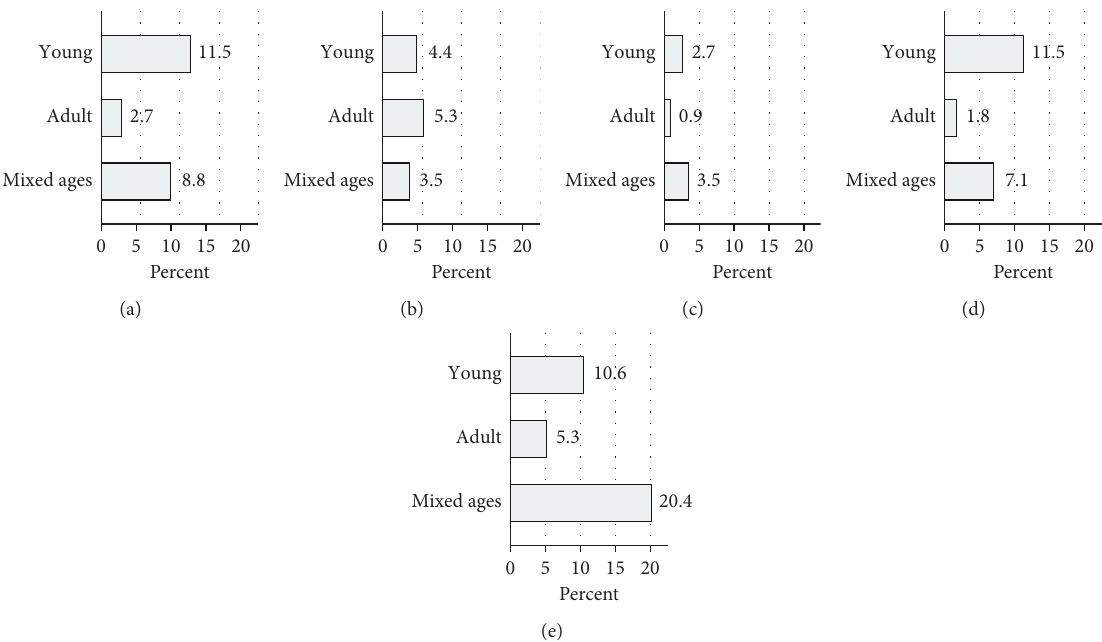
Figure 13: Age distribution of fish reported dead in the different subcounties. There were more deaths recorded in young fish in Kieni East, Othaya, and Tetu subcounties. Kieni West and Tetu recorded higher deaths in adult fish, while Tetu subcounty recorded more deaths in both young and adult fish. (a) Kieni East. (b) Kieni West. (c) Nyeri. (d) Othaya. (e)